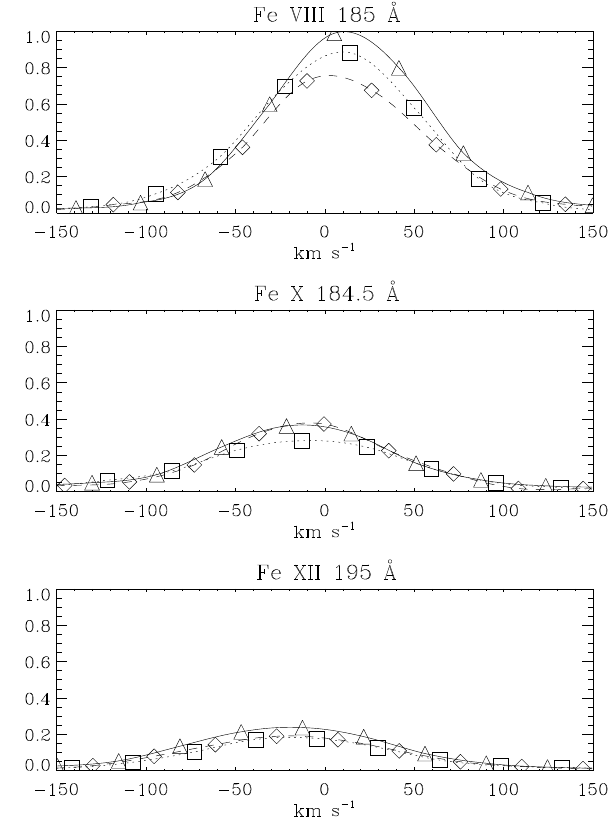
Figure 2. Observed line profiles for three pixels chosen from the outflow region seen in Fig. 1. The different line styles distinguish the different pixels and the symbols indicate the corresponding ob- served data points; the gaps are filled via interpolation. The top pro- file is for the 185Å Fe VIII (4 × 10 5 K) emission line, the middle profile is for the 184Å Fe X (1 × 10 6 K) line, and the bottom profile is for the 195Å Fe XII (1.3 × 10 6 K) line. This ordering of lines is consistent throughout the